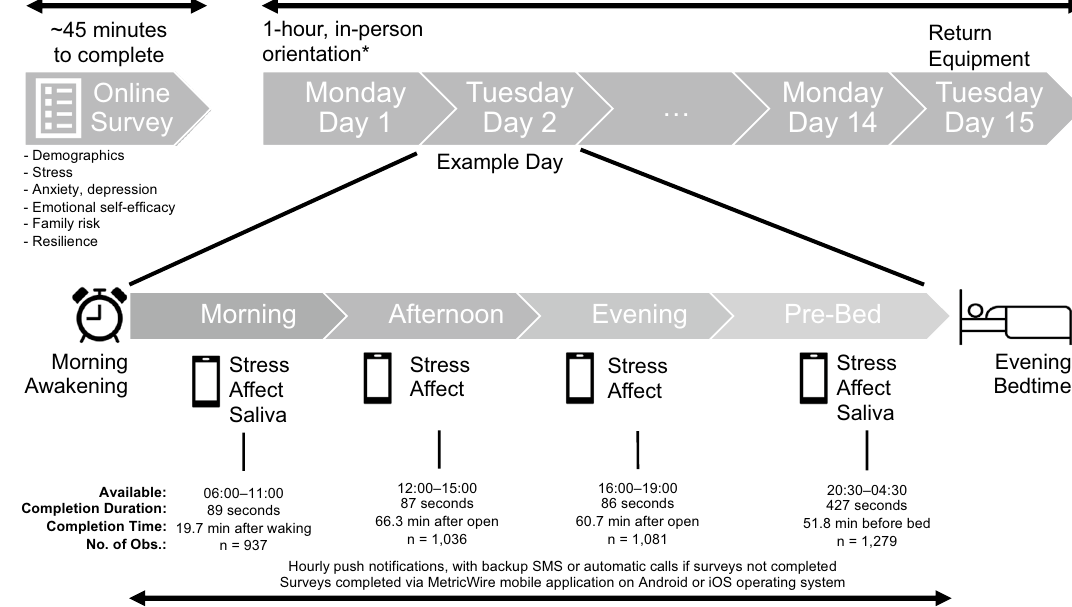
Figure 1. Study Procedure and Survey Completion. All participants started on Mondays and ended on Mondays, providing 10 weekdays and 4 weekend days. All surveys were closed outside their respective time windows to prevent retrospective reports. Stress and affect survey questions were identical over time to reduce participant burden, with some additional questions (not explored in this study) at the pre-sleep survey, resulting in longer completion time. Median completion time was preferred over mean time as it was possible that participants partially attempted surveys and completed them at a later time, leading to artificially longer completion duration. Participants received hourly push notifications (an average of 4 prompts), with backup SMS or automatic calls if surveys were not completed within time window. Surveys were completed via with instruction manuals for completing surveys and saliva collection. *Participants who joined the study during COVID-19 restrictions were given the instructions through a recorded video and supported through teleconference platform Zoom. Subjects could reach a member of the research team by telephone if they had questions or problems during the sampling period. This period is expected to be a moderate stress period where university students are addressing daily hassles during an academic period of completing assessments or sitting for mid-semester examinations. All daily studies were timed to start during the academic semester and to avoid starting during holidays or break